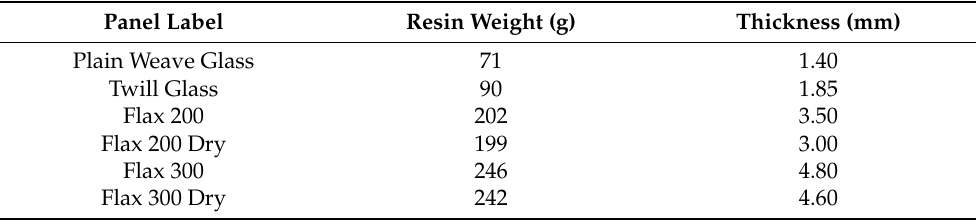
Table 4. Physical properties of composite panels. Panel